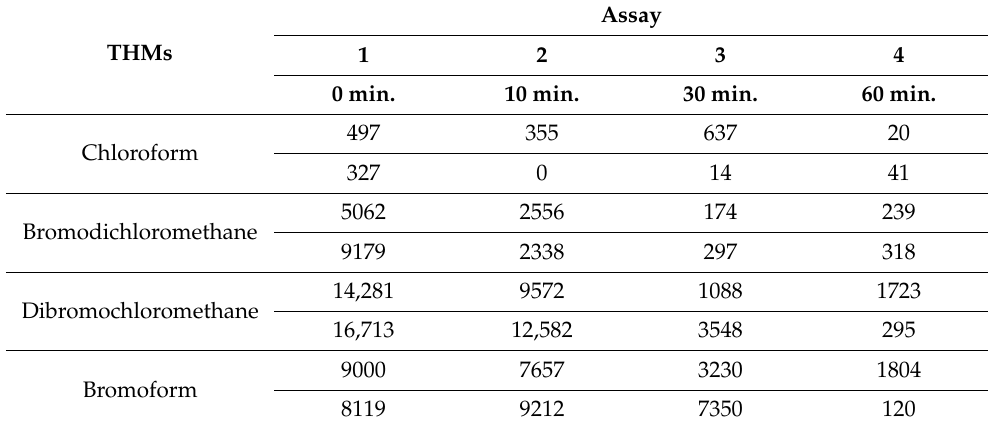
Table 3. Results (peak area) by replicate measurements of desorption time optimization.